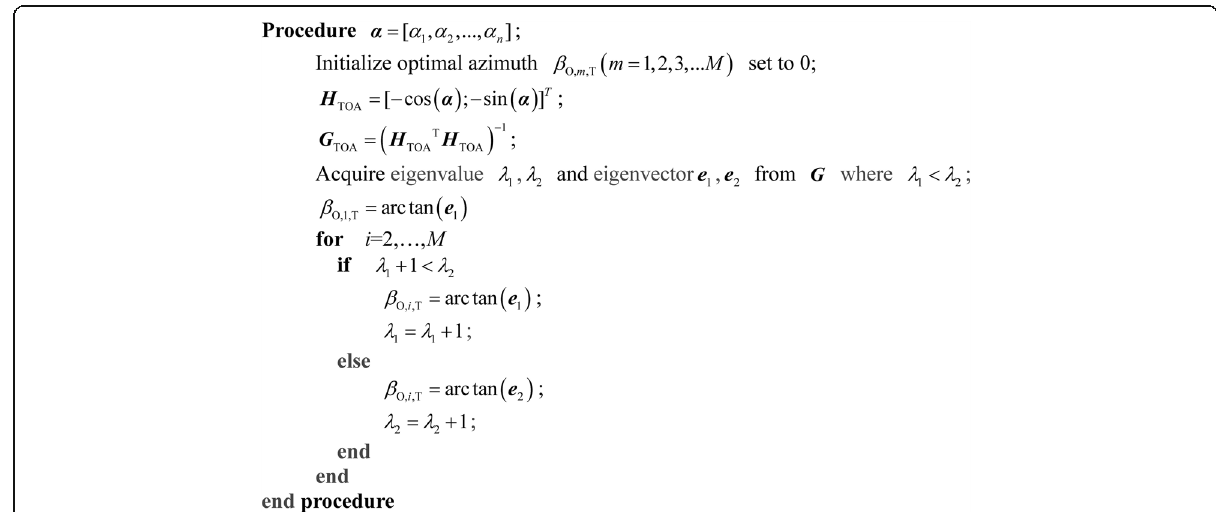
Fig. 10 Pseudocode for the deployment procedure in eigenvalue-based approach towards TOA-based localization system